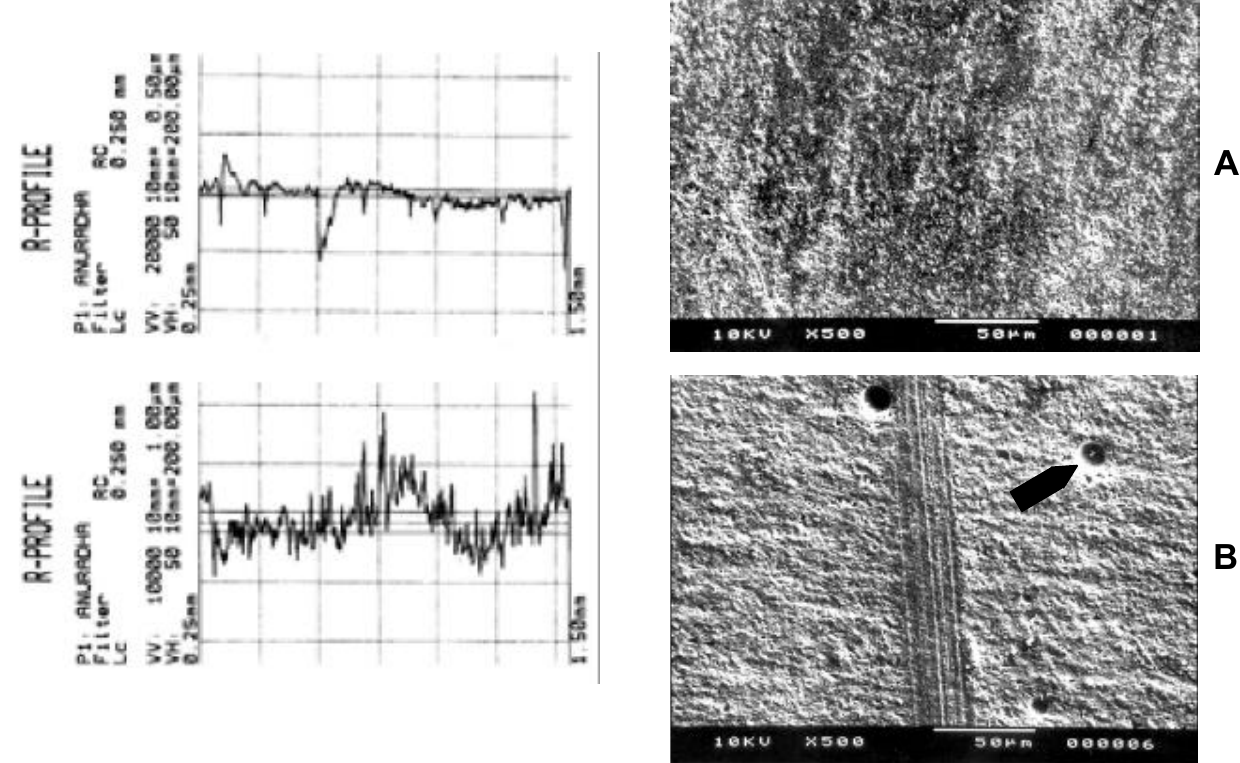
FIGURE 1 - Roughness and microscopic evaluation of Enforce (Dentsply) resin cement before (a) and after (b) brushing simulation